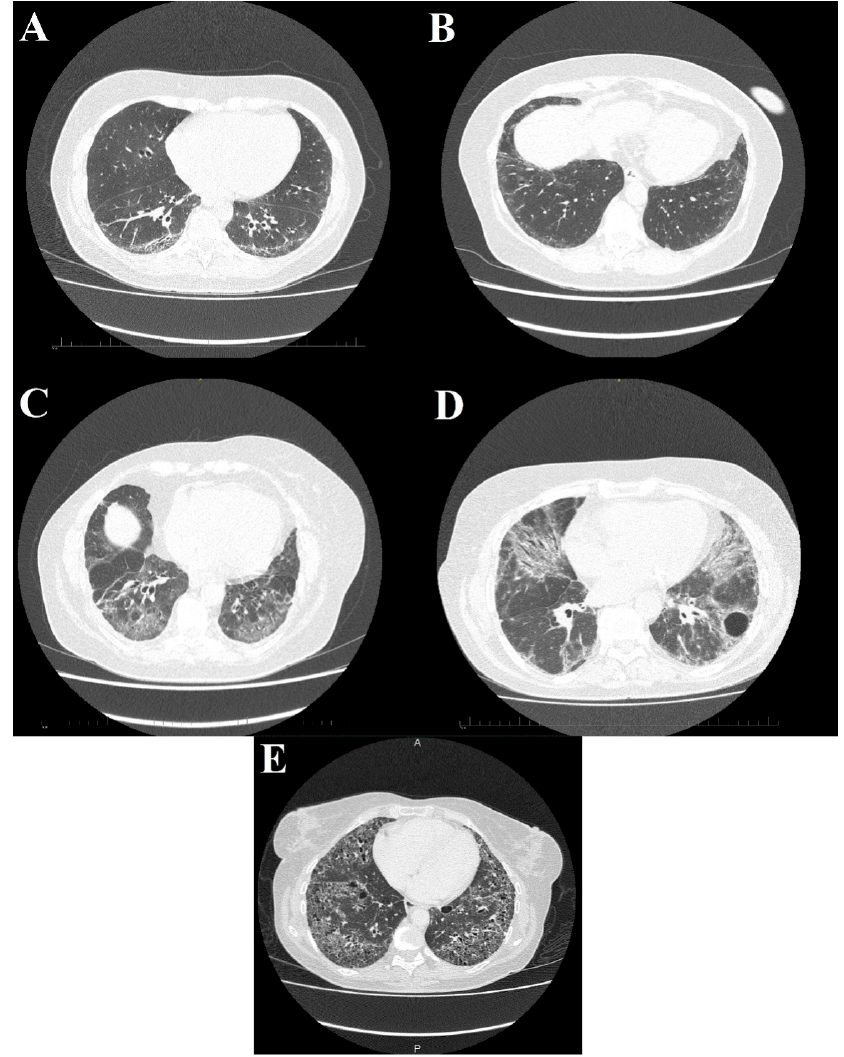
Figure 5. High-resolution computed tomography scans show different stages of systemic sclerosis- related interstitial lung disease. ( A ) Reticular, linear, and minor ground glass opacities; ( B ) ground glass opacities peripherally in the basal parts of the lower lobes; ( C ) diffuse ground glass, reticular opacities with discreet interlobular septal thickening in the basal parts of the lower lobes; ( D ) ground glass opacifications with reticular and linear patterns with traction bronchiectasis with an additional bulla; and ( E ) interstitial opacifications with extensive honeycombing.